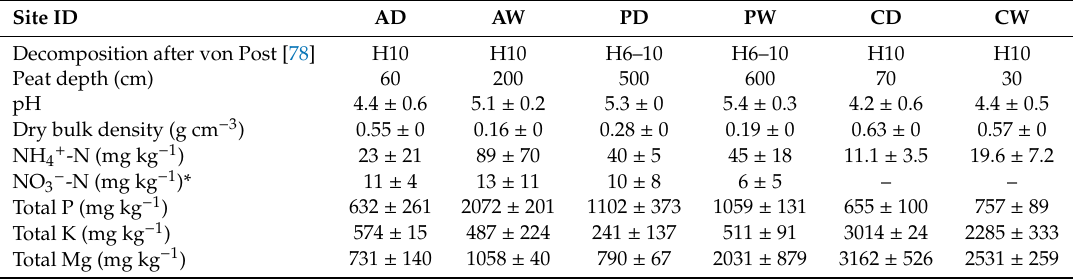
Table 2. Some peat characteristics of the WETSCAPES study sites. Dry bulk densities refer to 10–20 cm below surface, all other peat chemical parameters to 0–20 cm below surface. NO 3 − -N in CD and CW was below detection